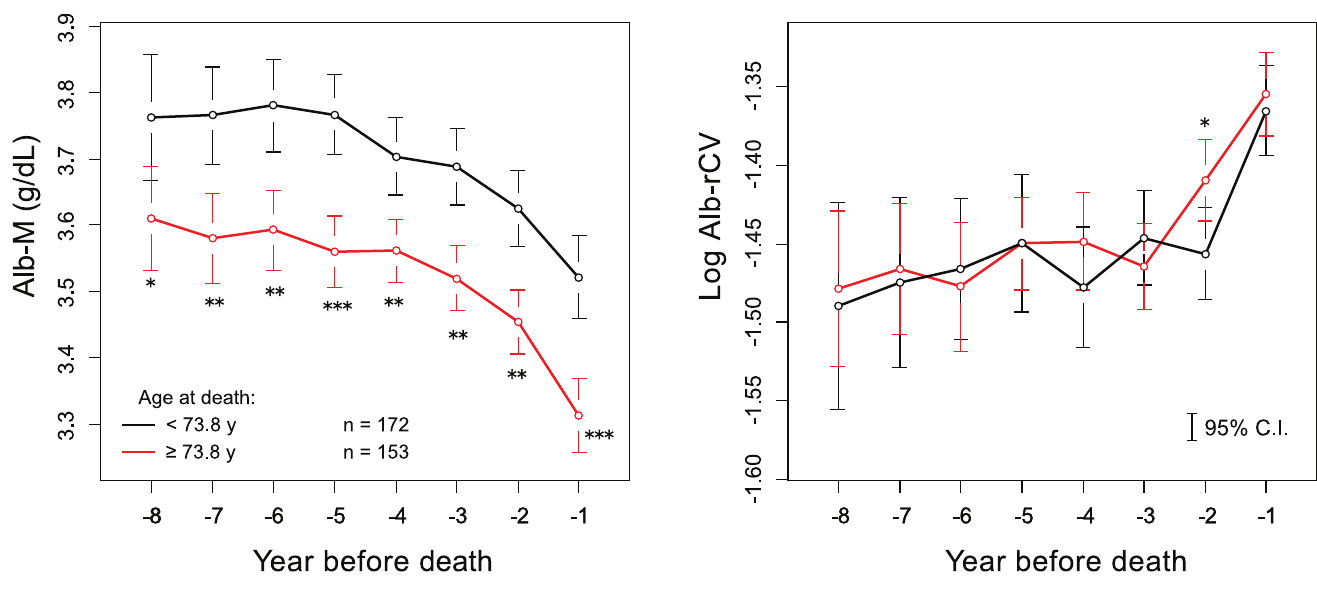
Fig 5. Age and albumin dynamics prior to death. The before death subcohortwere dividedinto 2 groups accordingto the subject’s age at death (mean: 73.8 years), and the yearly mean values of both groups were compared using an unpairedt-test. *** P < 0.001, ** P < 0.01, * P < 0.05.